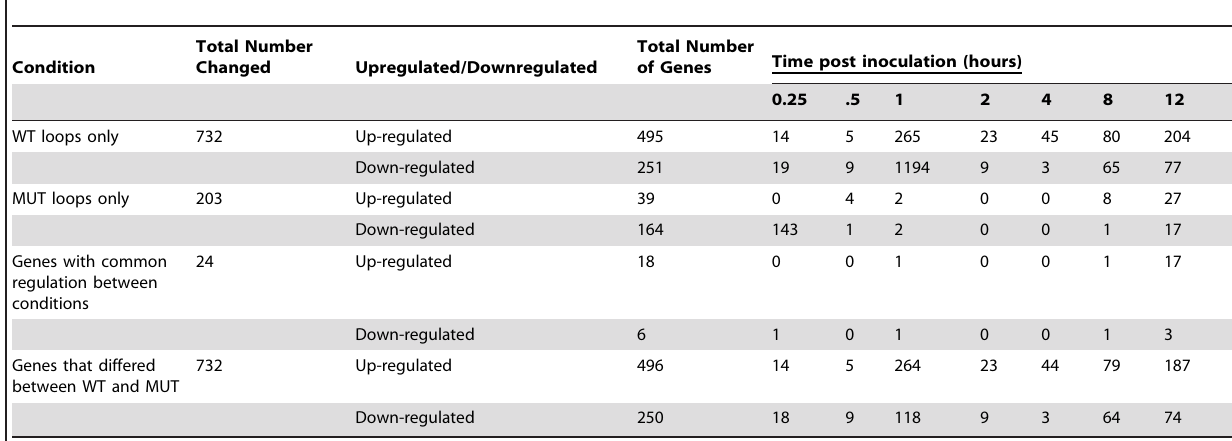
Table 2. Summary of significant genes determined by t test using cutoff p value # 0.05 and |fold-change| $ 1.5 in response